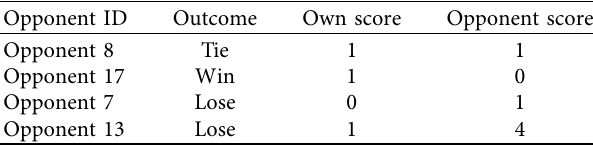
Table 6: Results of four games.